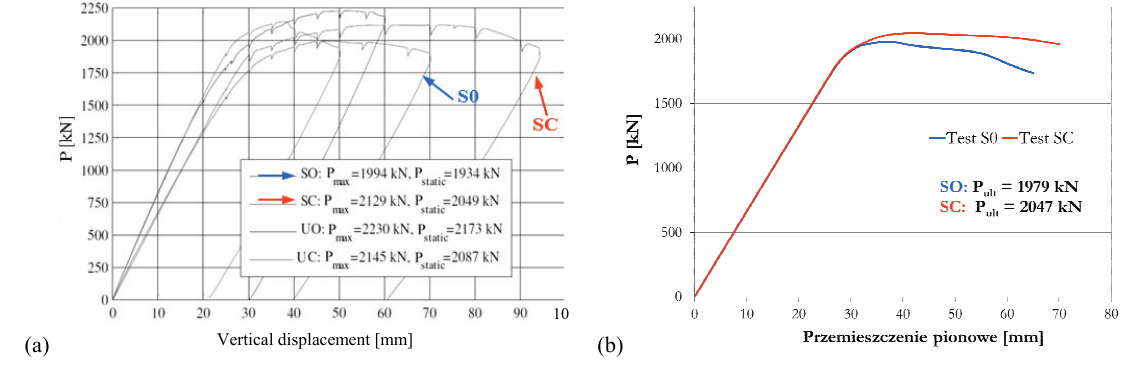
Fig. 8. Static stability paths (SSP): (a) experimental results (Sinur